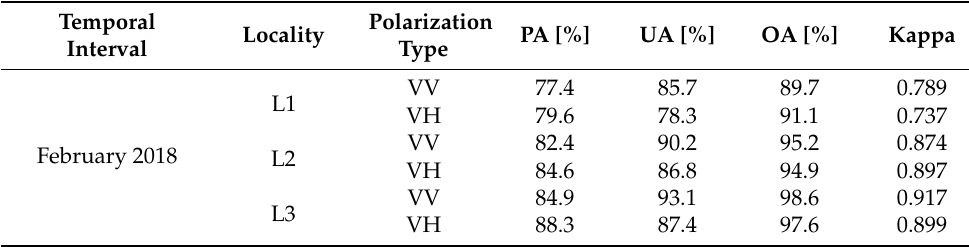
Table 4. The comparison of accuracy evaluation of water bodies extraction using VV and VH polarisation configuration in 02/2018.